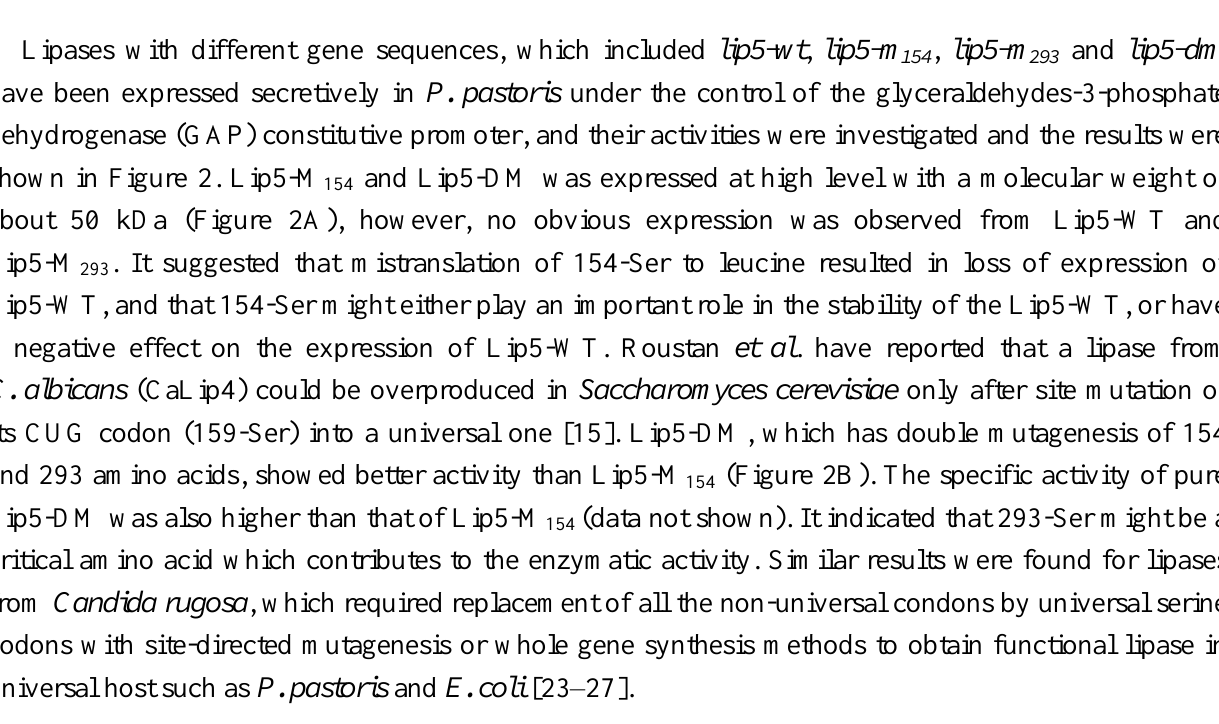
Figure 2. ( A ) Lane M: molecular weight marker; lane 1: Sample from wild type Lip5 expression medium; lane 2: Sample from Lip5-M154 expression medium; lane 3, sample from Lip5-M293 expression medium; lane 4: Sample Lip5-DM expression medium; lane 5: sample from transformant harboring pGAPZαA expression medium; ( B ) The activity of Lip5-WT and mutants in the culture supernatant were measured spectrophotometrically with p -NP - caprylate as substrate at 25 °C and pH 6.0. Activities are displayed as percentages of the maximum activity (Lip5-DM, 4000